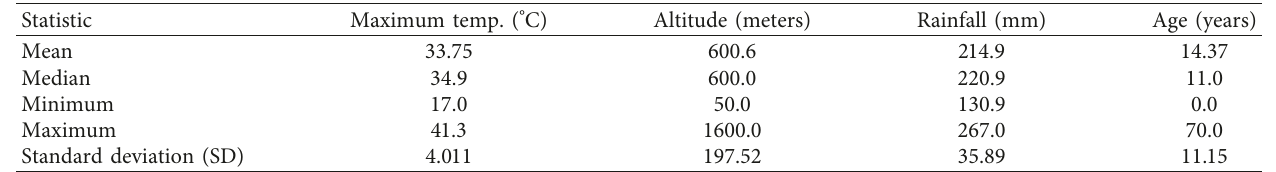
Figure 4: Municipalities of Chiapas with confirmed cases of dengue. Table 1: Descriptive statistics of